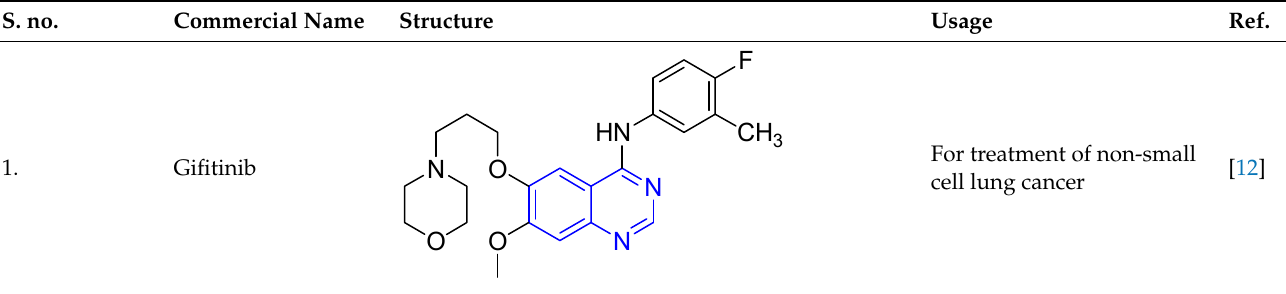
Table 1. Quinazoline based commercial